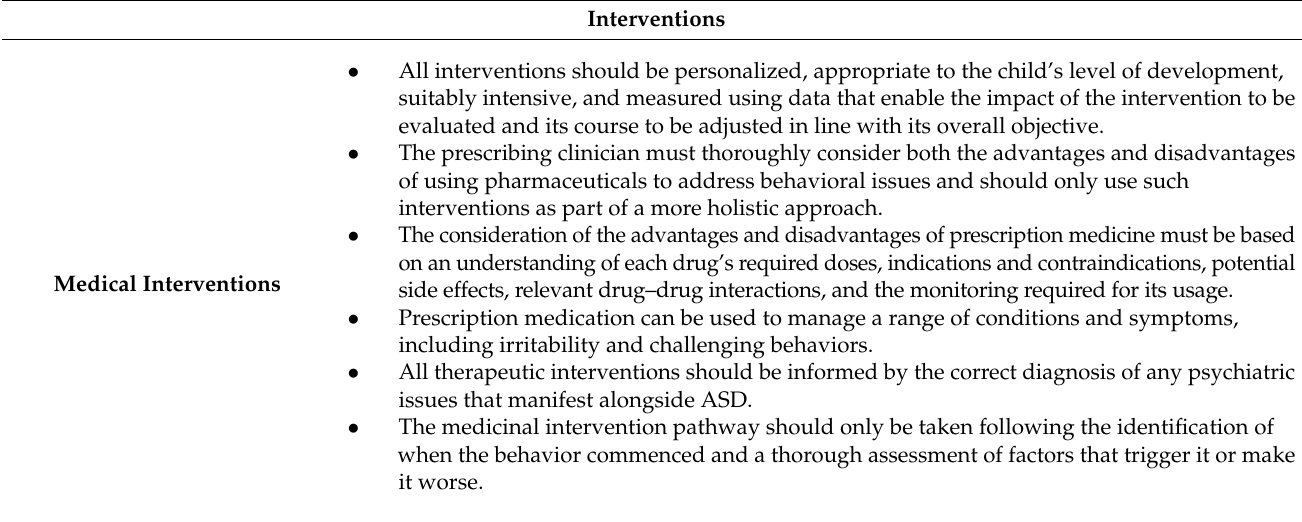
Table 3. Recommendations for